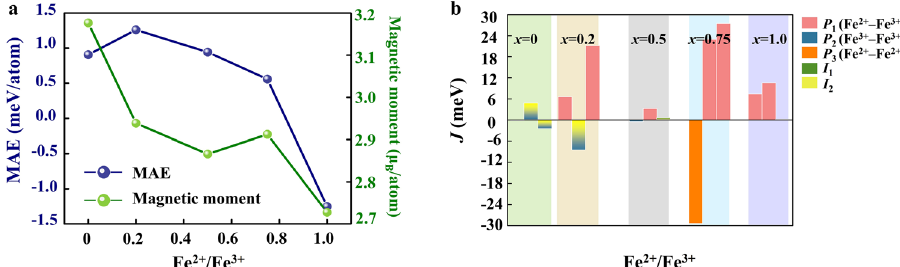
Fig. 3 Magnetic properties of multilayer Fe n GeTe 2 . a Calculated magnetic anisotropy energy (MAE) and magnetic moment per atom for various Fe 2 + / Fe 3 + ratios ( x ). The detailed data are listed in Table 1. b Exchange parameters for fi rst, second, and third nearest neighbors (see Supplementary Fig. 9). The green, gold, gray, blue, and purple regions correspond to x = 0, 0.2, 0.5, 0.75, and 1.0,